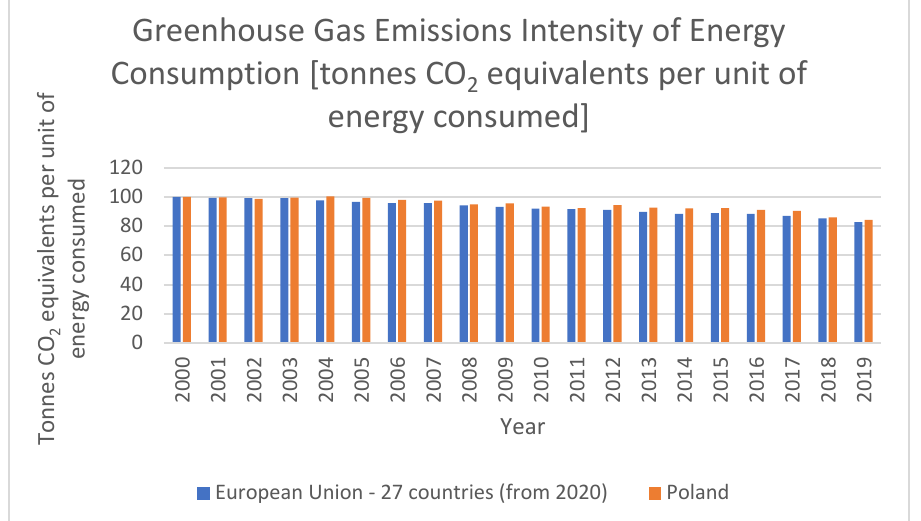
Figure 5. Greenhouse gas emission intensity in terms of energy consumption (tonnes CO 2 equiva- lents per units of energy consumed) — Poland vs. EU-27 over the period 2000 – 2019. Source: Own elaboration based on Eurostat data [29].